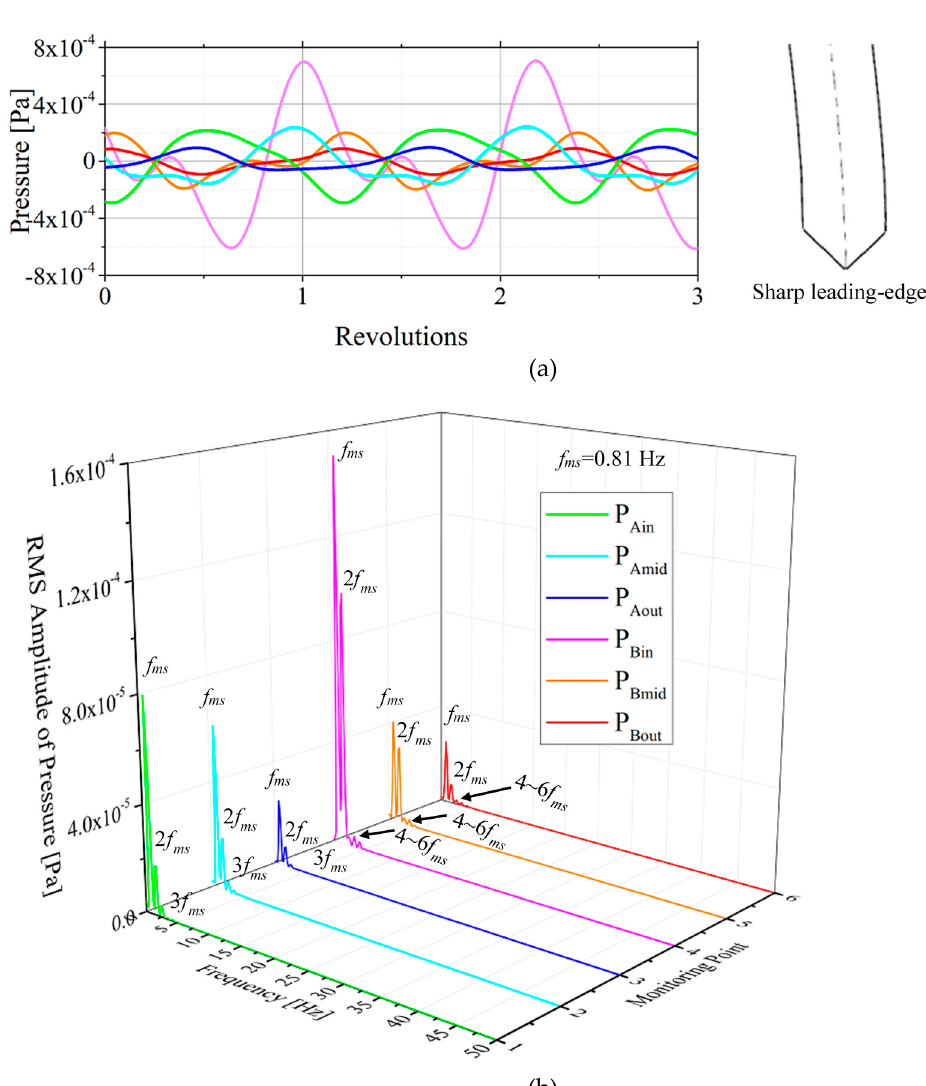
Figure 16. Pressure pulsation in the sharp leading-edge impeller: ( a ) time-domain plot (three revolutions); ( b ) frequency-domain plot, monitor points (1) P Ain , (2) P Amid , (3) P Aout , (4) P Bin , (5) P Bmid , and (6) P Bout .